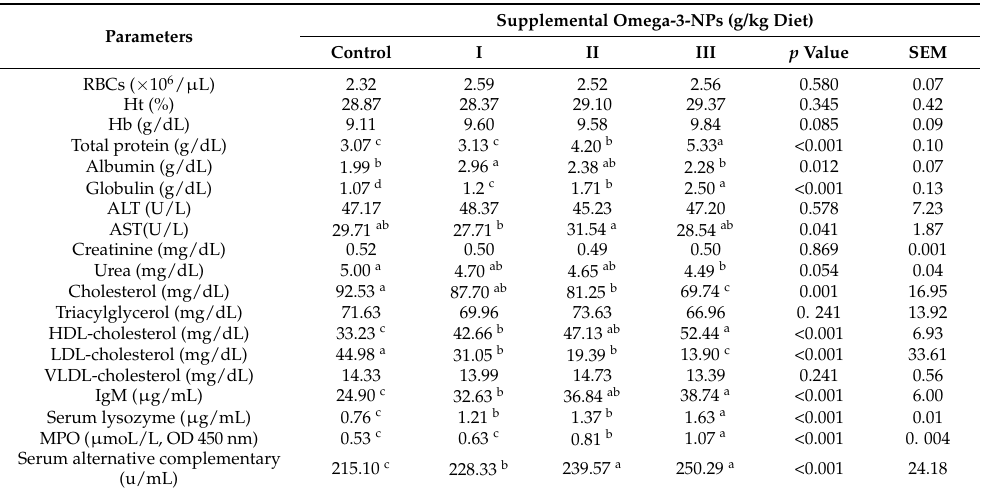
Table 6. Hematological and immunological indices and lipid peroxidation and antioxidant biomarkers of Nile tilapia ( O. niloticus ) fed diets supplemented with variable levels of omega-3-NPs for 12